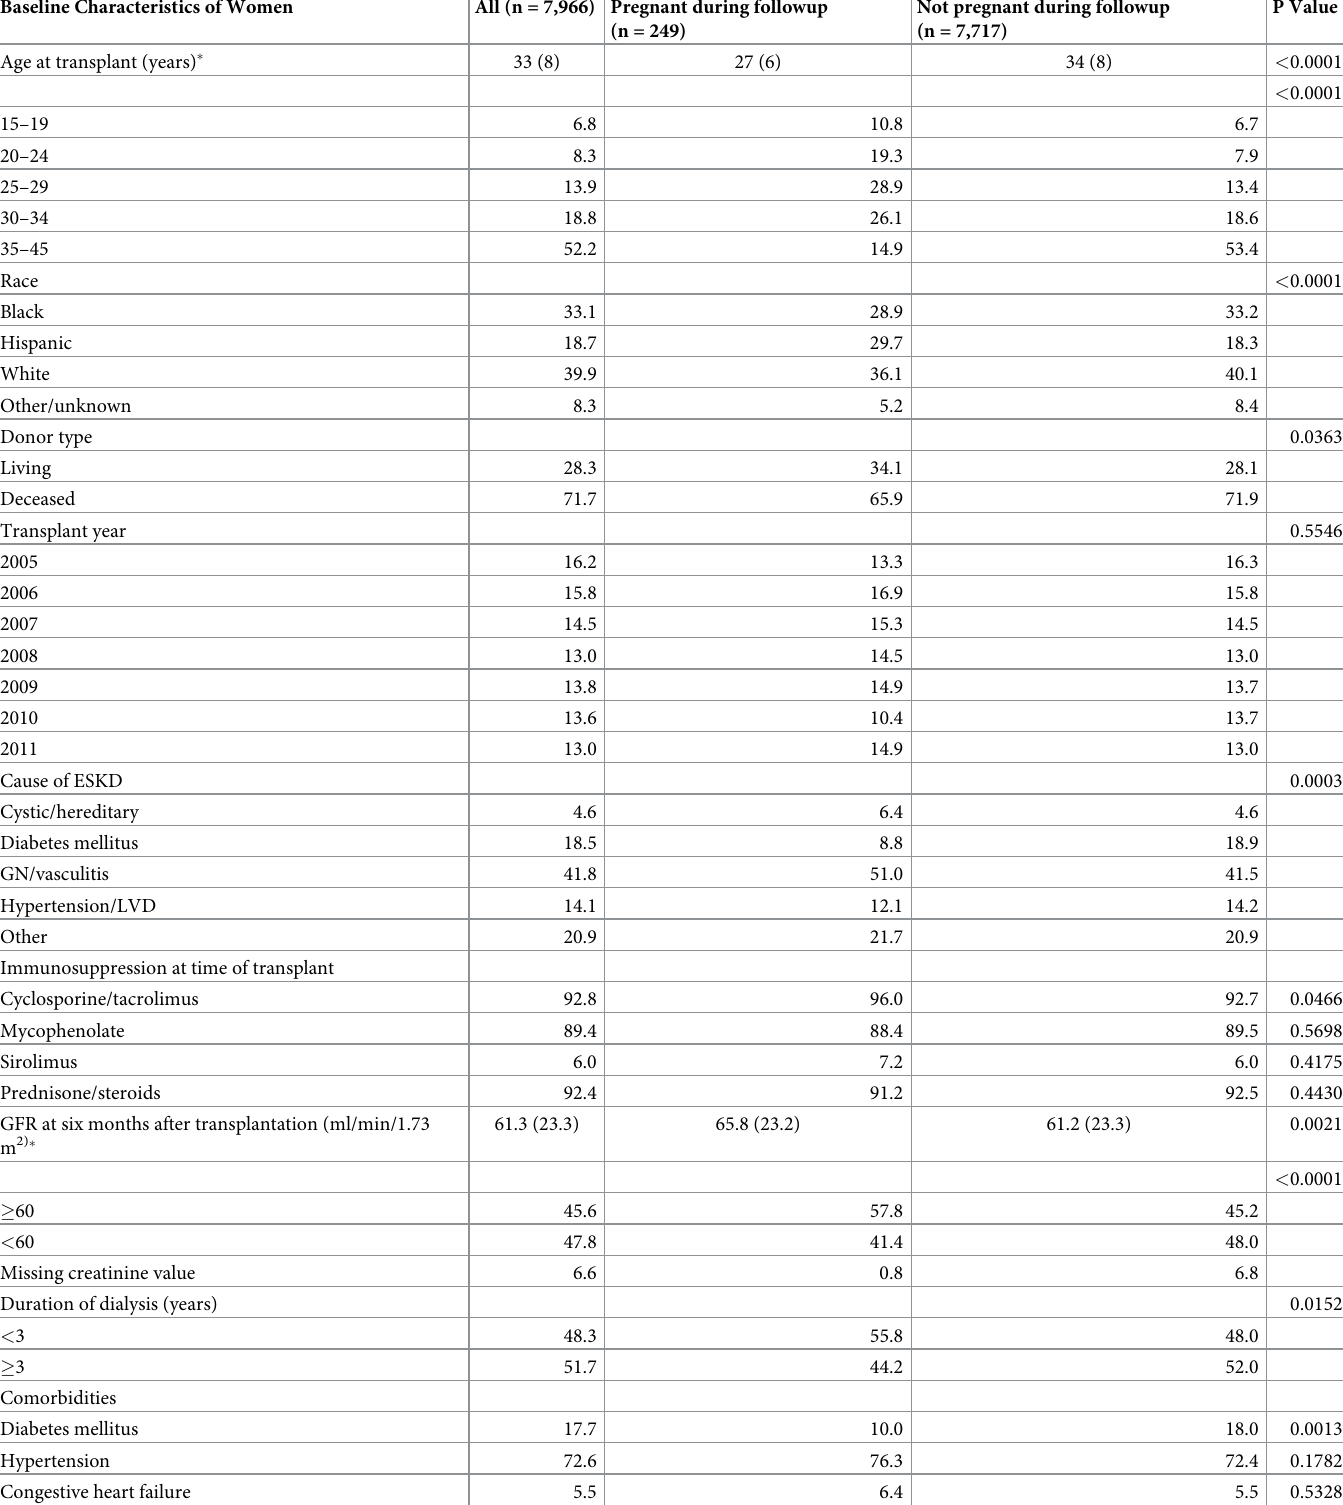
Table 1. Baseline characteristics of women of childbearing age separated by pregnancy during the follow-up period. Baseline Characteristics of